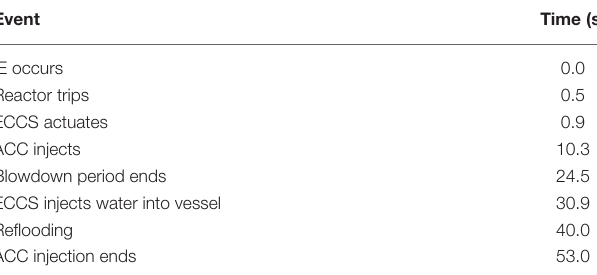
TABLE 5 | Accident sequence of SB-LOCA in FSAR report (Cd = 0.4).